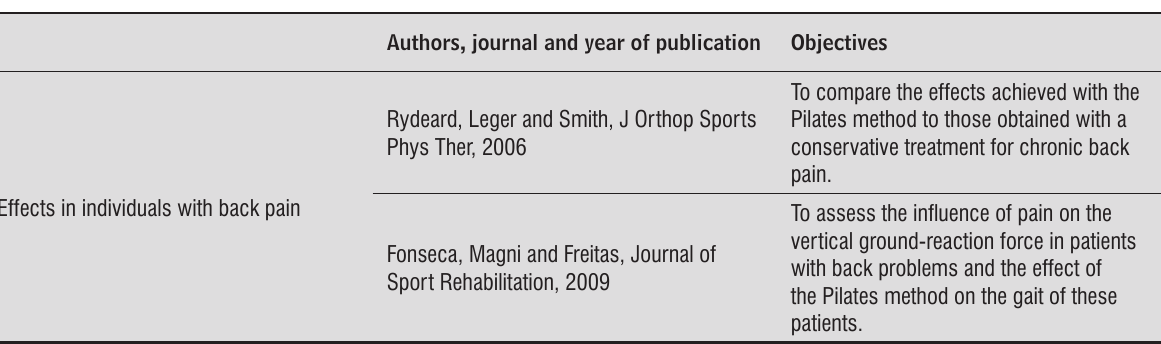
Table 3 - Stabilization exercises based on the Pilates ®